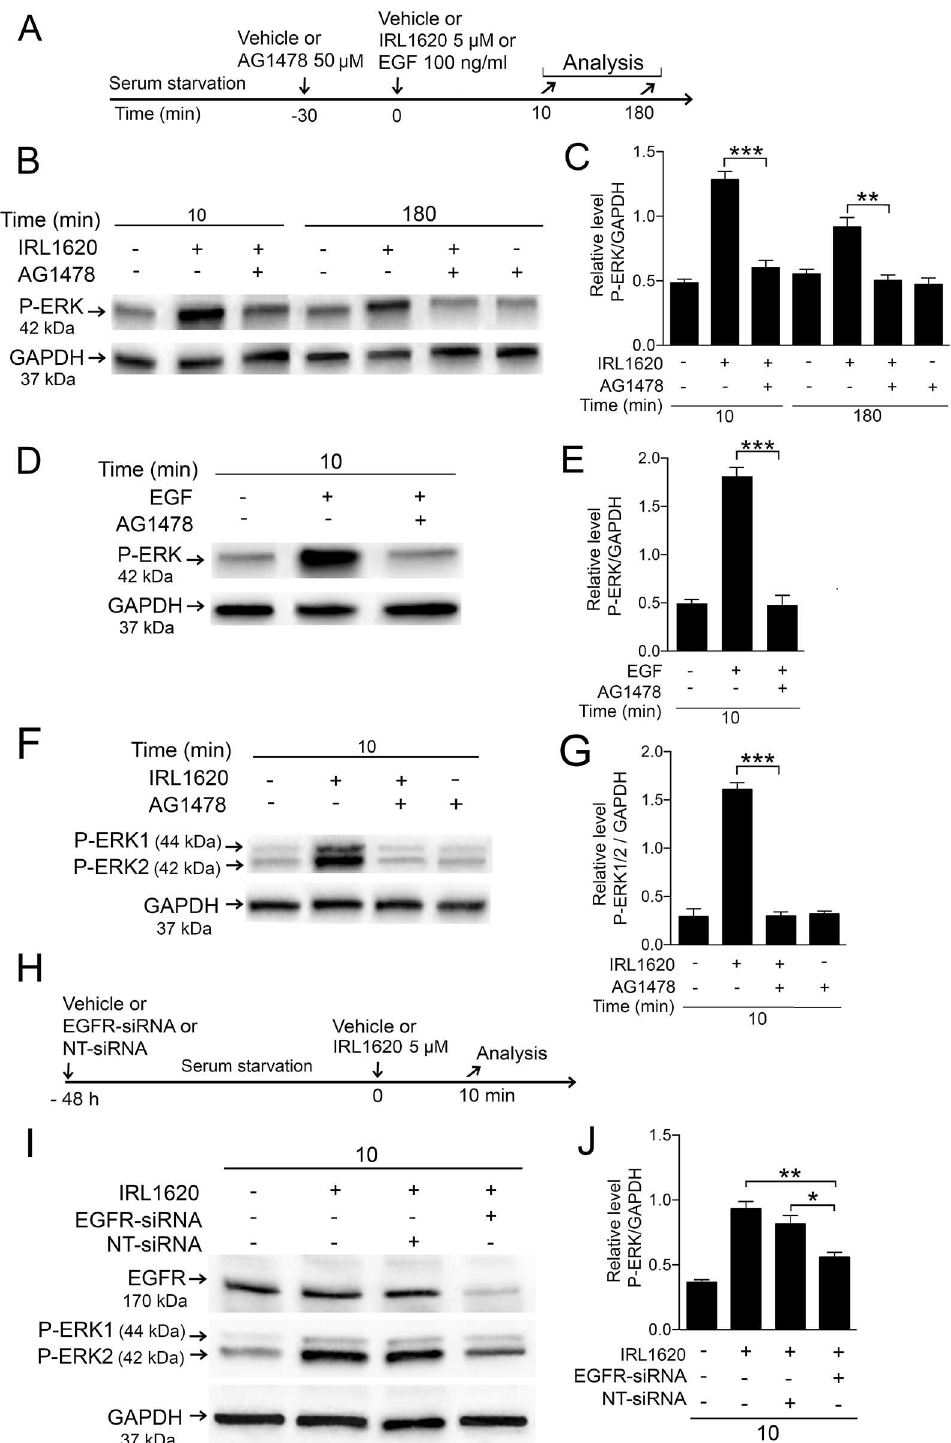
Fig 6. Effects of EGFR kinase inhibitor AG1478or EGFR-siRNA on IRL1620-induced P-ERK1/2 levels in Mu¨ller cells. Serum-starved primary chicken Mu¨ller cells and human MIO-M1 cells pretreated with 50 μ M AG1478 or control (vehicle) for 30 min followedby treatment with 5 μ M IRL1620or vehiclefor 10 and 180 min of chicken Mu¨ller cells, and for 10 min of humanMIO-M1 cells. (A) Experimental outline.(B-G) Western blot analysesof P-ERK levels in (B, C) chicken Mu¨ller cells treated with IRL1620and AG1478,